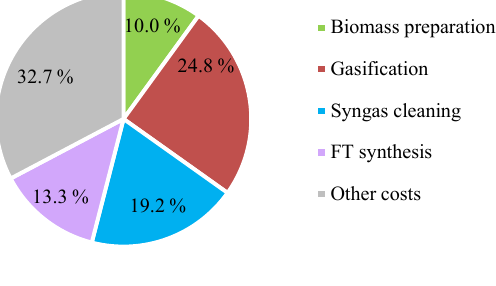
Fig. 2. Breakdown of capital costs.